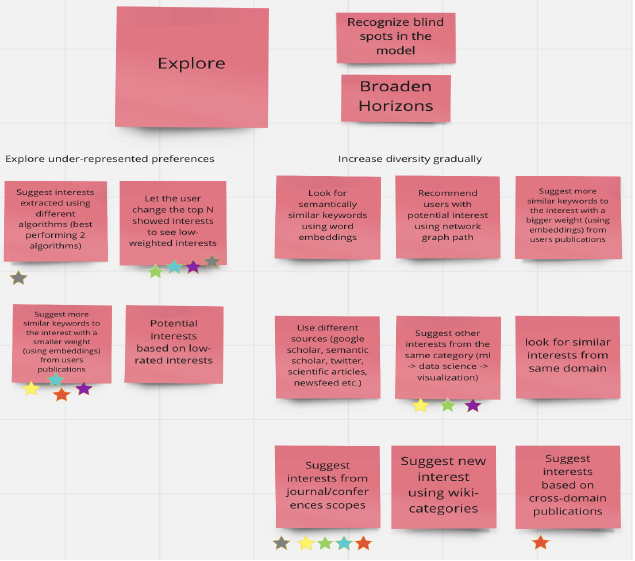
Figure 3. Results of the ideation phase in the first iteration related to the goal Explore